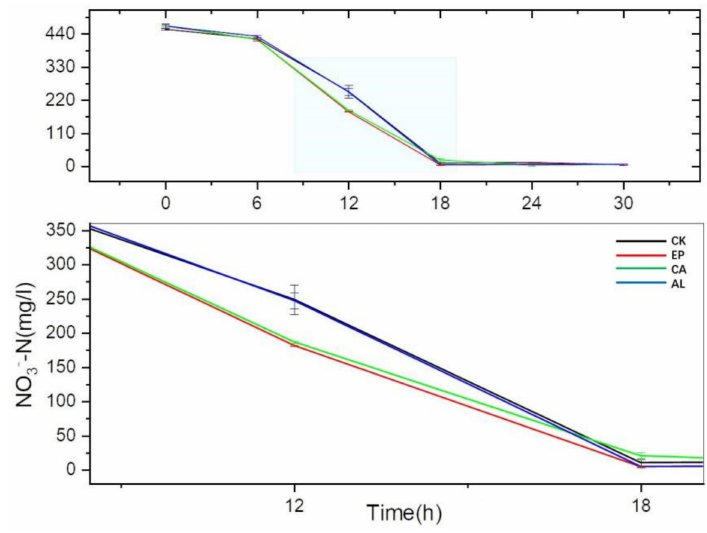
Figure 4. The changes of NO 3 − -N concentration with culture time.